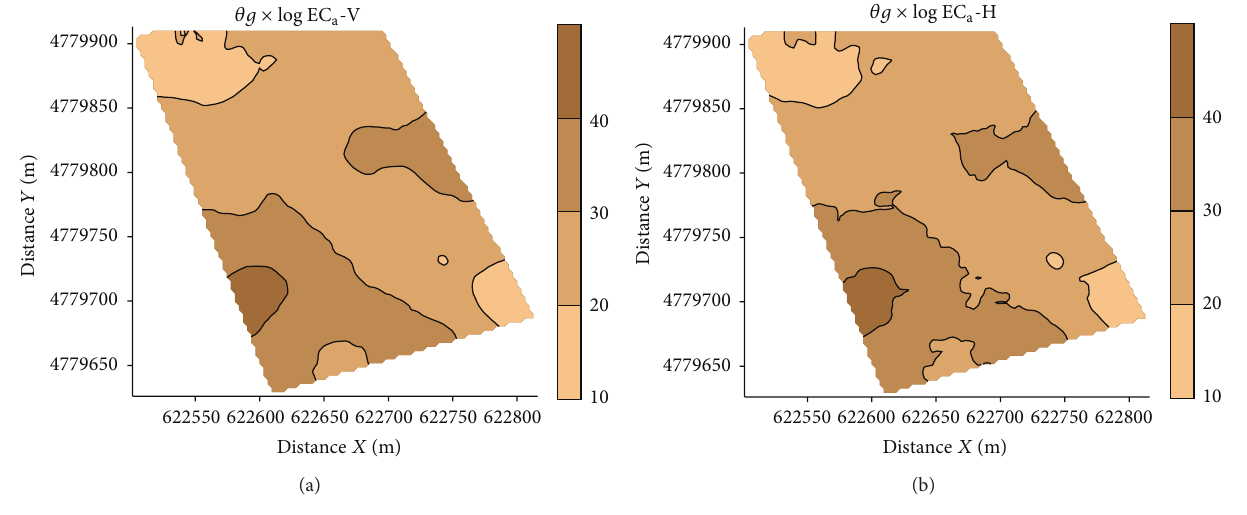
Figure 7: Map of gravimetric water content, 𝜃𝑔 , obtained by the universal cokriging. Table 5: Fitted semivariogram parameters and respective models of the continuously recorded EC